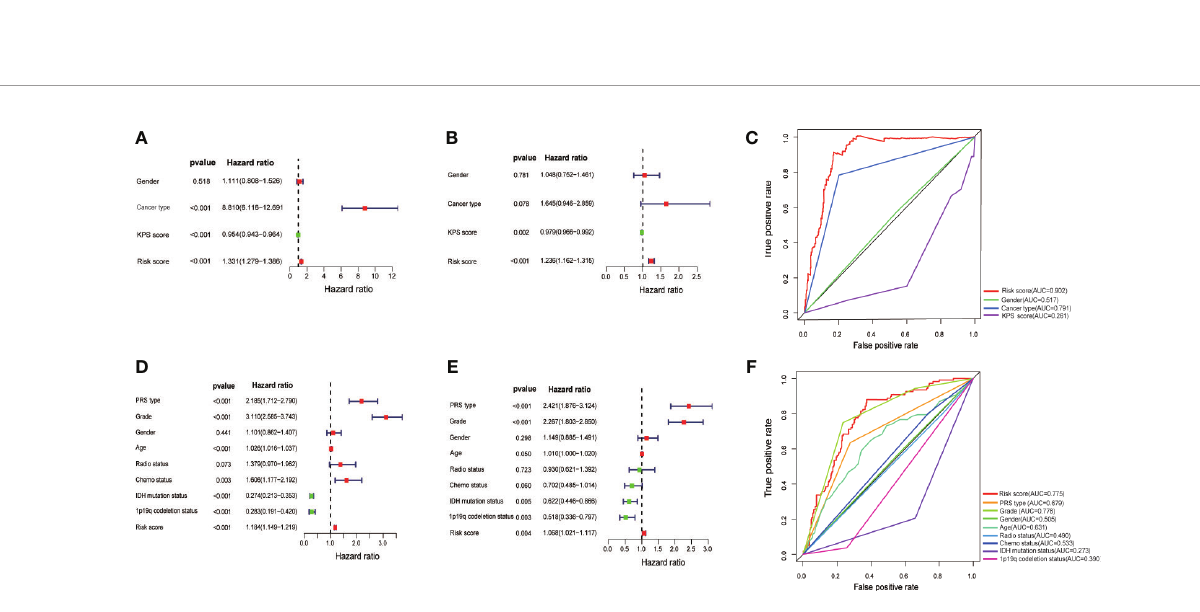
FIGURE 5 | Assessment of the independent prognostic value of the risk score model based on a 10 MES-related lncRNAs signature. (A) Univariate and (B) multivariate Cox regression analyses of risk score and other clinical factors in the TCGA data set. (C) The AUC based on the ROC curves for risk score and other clinical factors in the TCGA data set; Clinical factors: gender, cancer type, KPS score, risk score. (D) Univariate and (E) multivariate Cox regression analysis of risk score and other clinical factors in the CGGA data set. (F) The AUC for risk score and other clinical factors in the CGGA data set; Clinical factors: PRS type, grade. gender, age, radio status, chemo status, IDH mutation status, 1p19q codeletion status, risk